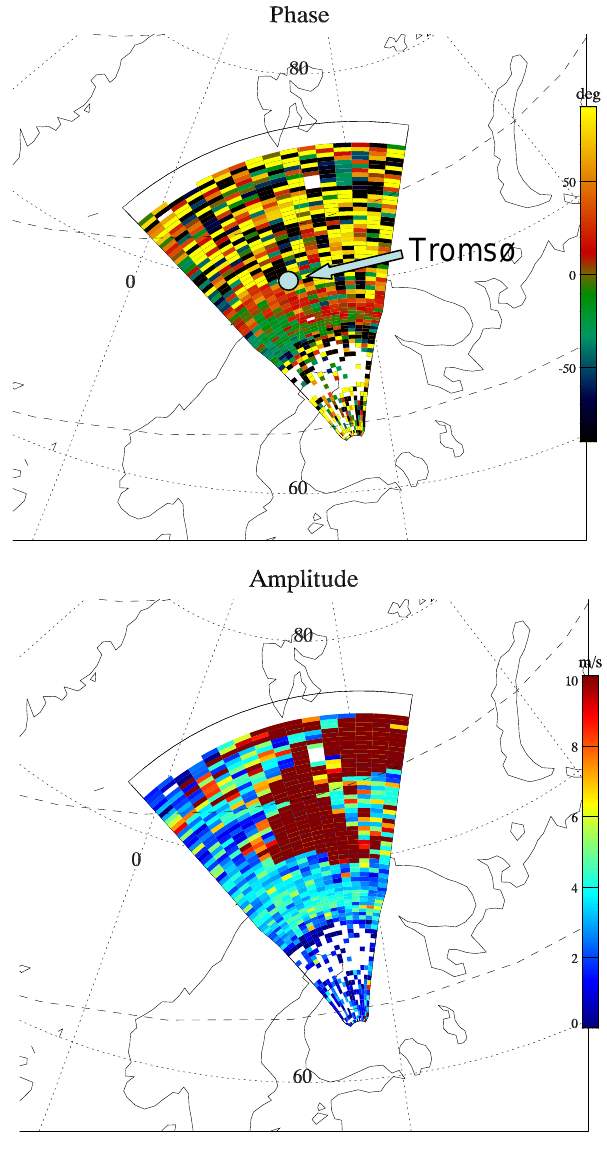
Fig. 9. Hankasalmi SuperDARN radar data for 16:30–17:30 UT, 25 March 2002. Spatial variation of the amplitude and phase of the Doppler velocity variations at